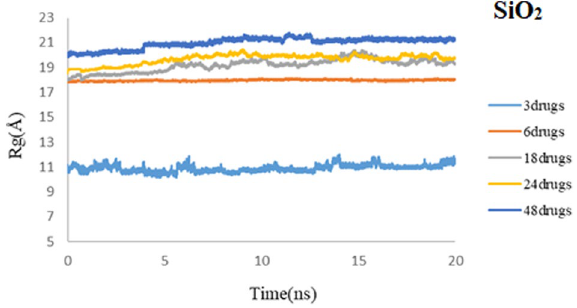
Figure 19. Rg values of 3TC adsorbed on SiO 2 for 3, 6, 18, 24, and 48 drug molecules.